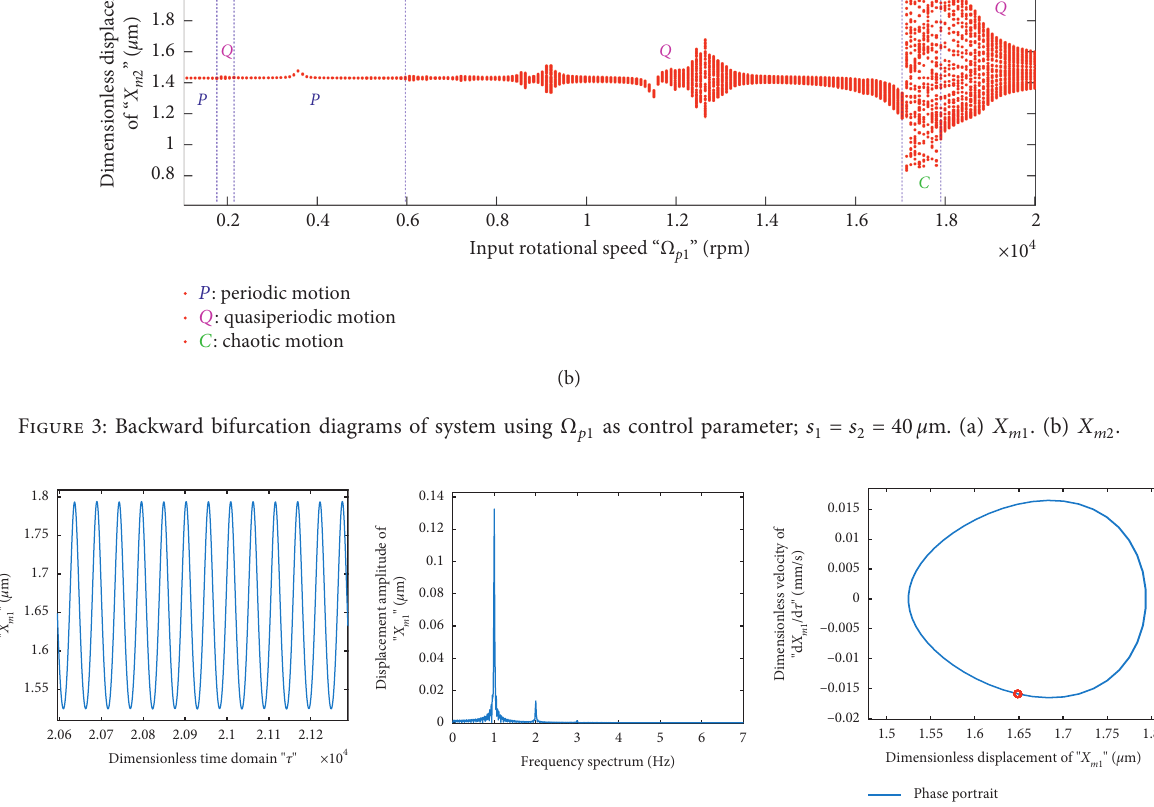
m 1 at 2500rpm. (a) Time-domain response. (b) FFT spectrum. (c) Phase plane and Poincar´e